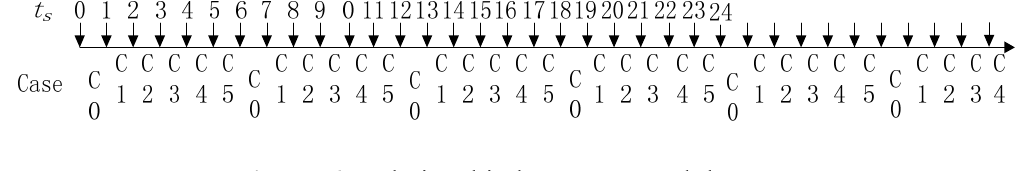
Figure 6. Relationship between t s and the